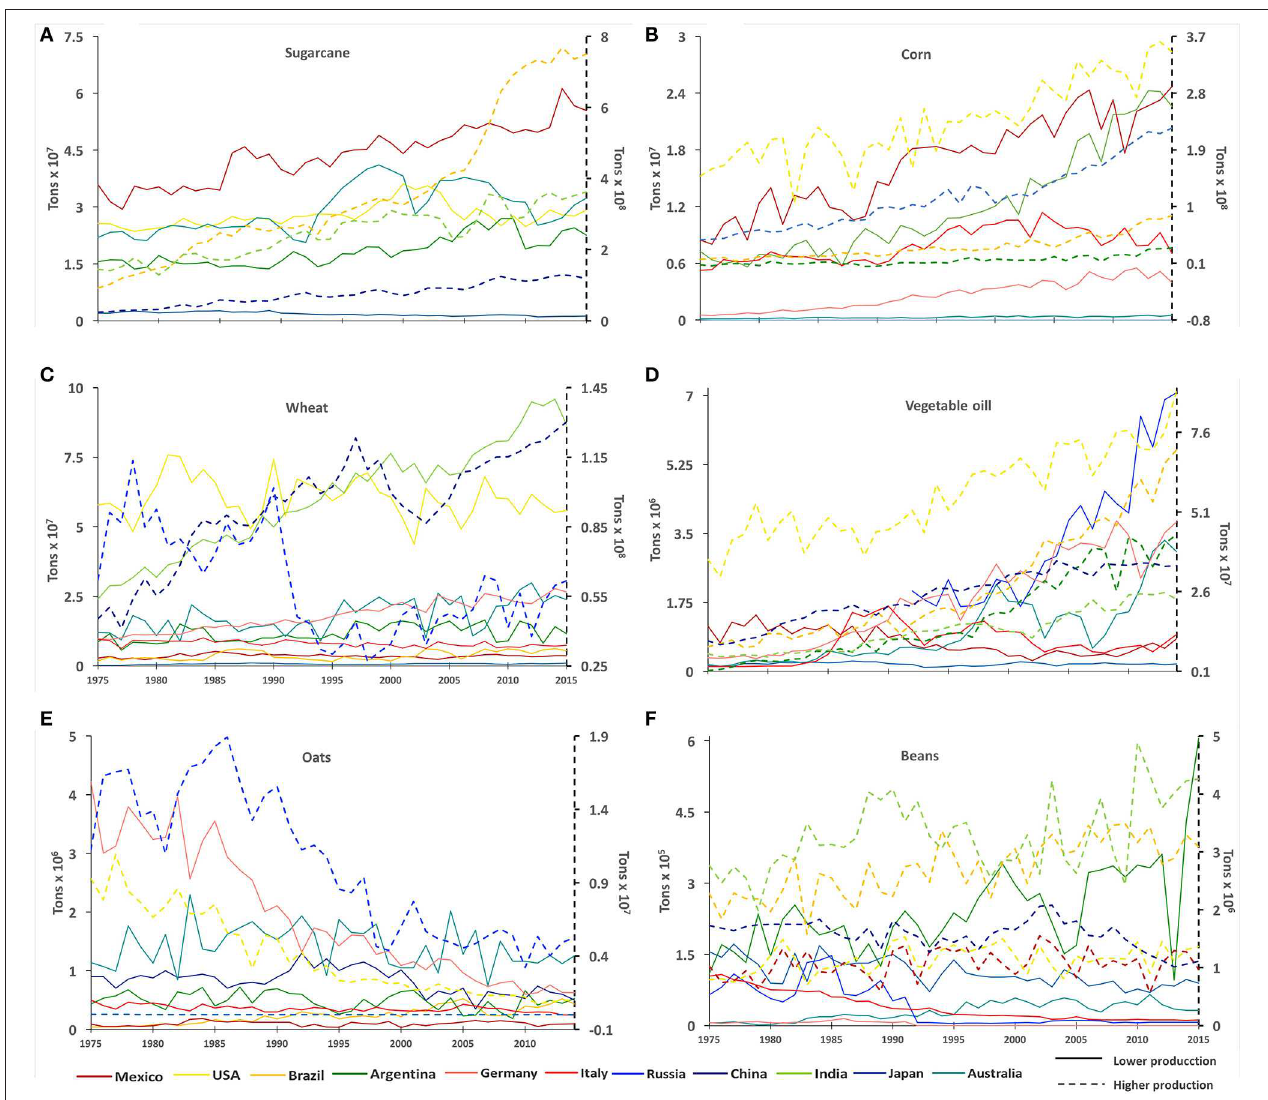
FIGURE 1 | Agricultural yields in a 40-year period of the world’s most consumed crops at the countries with the highest prevalence of NCD. (A) Sugar cane production, (B) corn production, (C) wheat production, (D) vegetable oil production, (E) oats production, and (F) beans production.